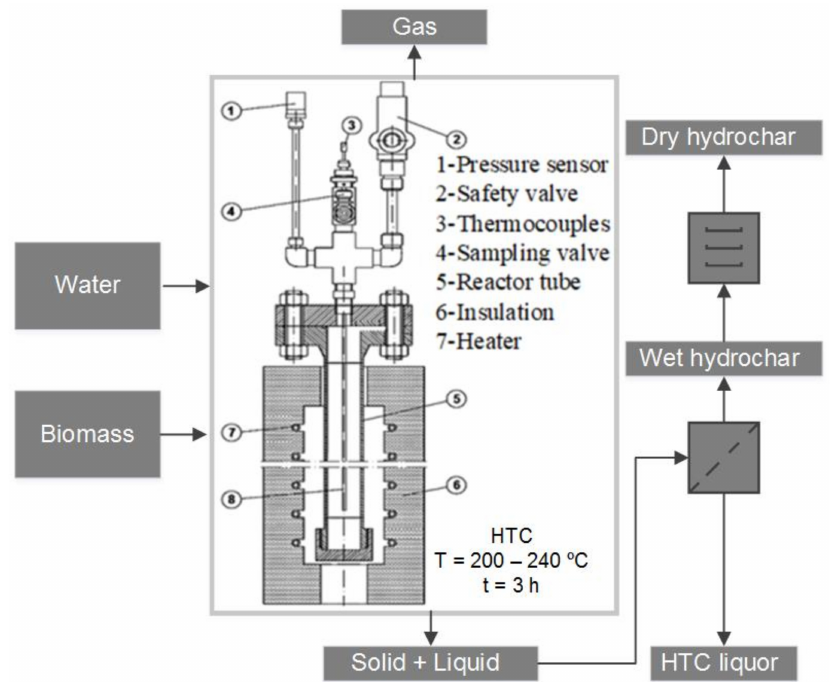
Figure 1. Hydrothermal carbonization (HTC) experimental unit and experimental